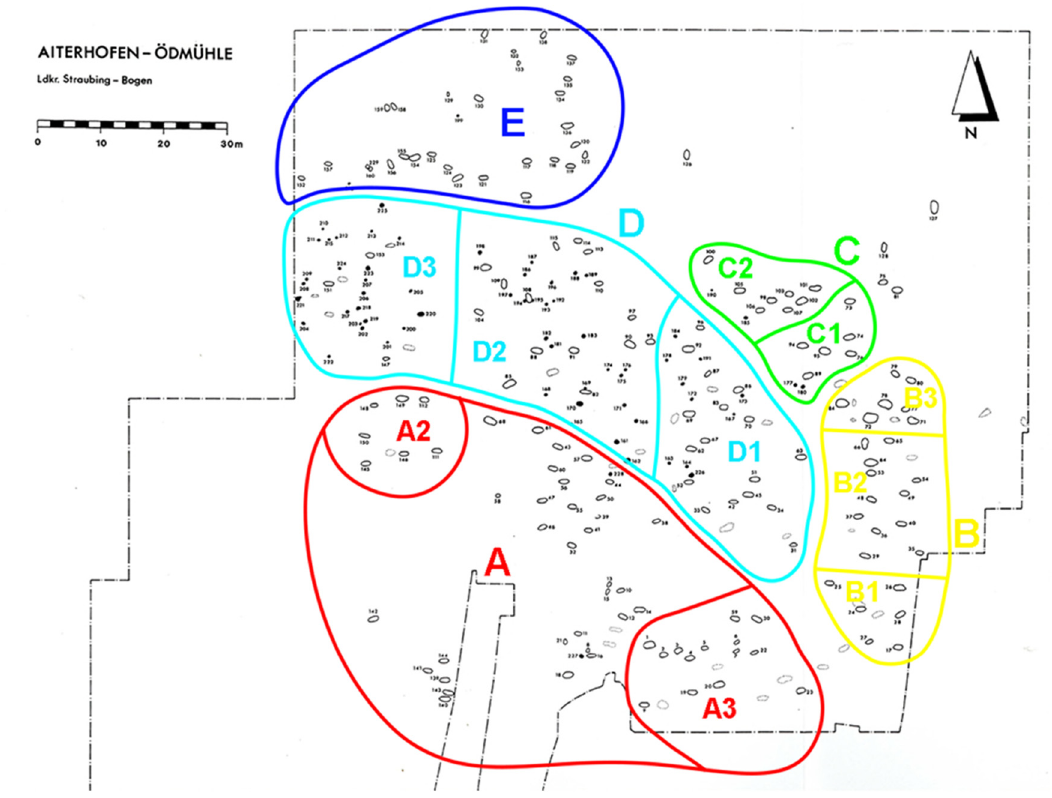
Figure 7: Spatial clusters as recommended for Aiterhofen - Ödmühle ( Hahnekamp, 2020, p. 197, Figure 52, after Nieszery, 1995, p. 54, Abb. 19 )